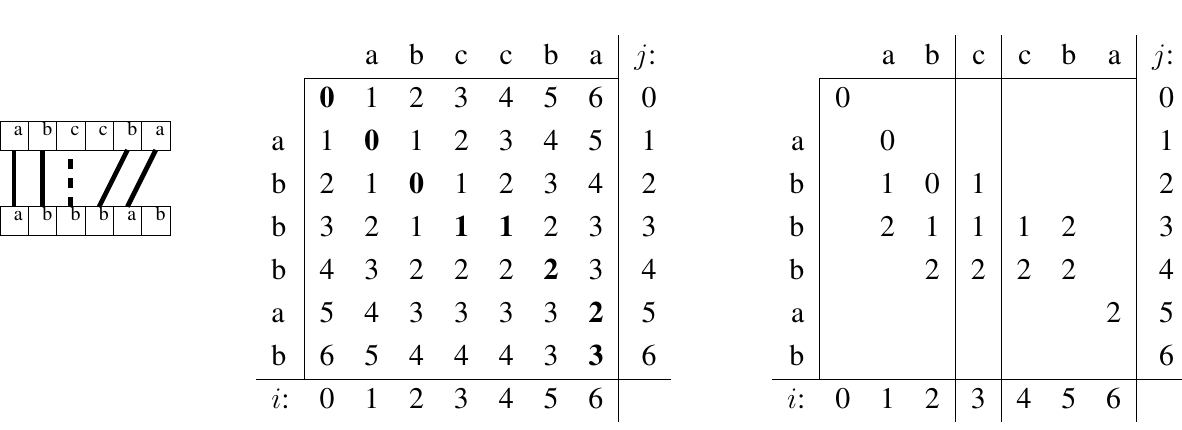
Figure 2. D table computation for strings abccba and abbbab . Left: schematic representa- tion of the alignment. Middle: computation of D . The numbers in bold correspond to the alignment shown on the left, and to the shortest path. Right: computation with increasing error